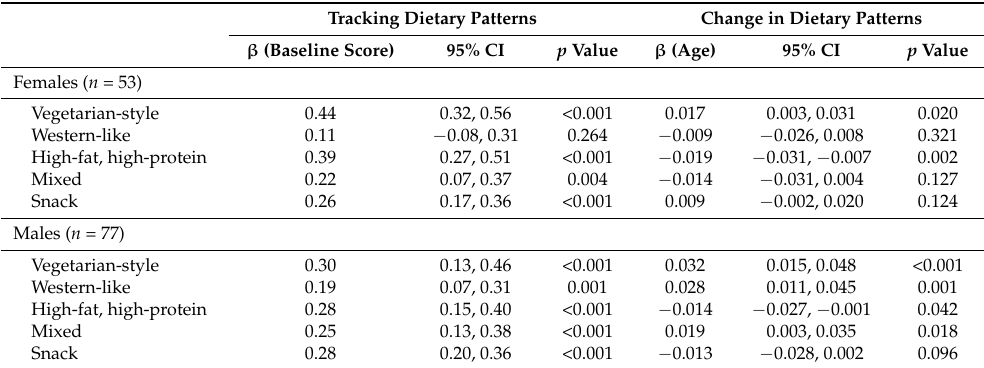
Table 3. Tracking coefficients of standardized dietary pattern score and change of standardized dietary pattern score by age in Pediatric Bone Mineral Accrual Study (PBMAS) participants a . Tracking Dietary Patterns Change in Dietary